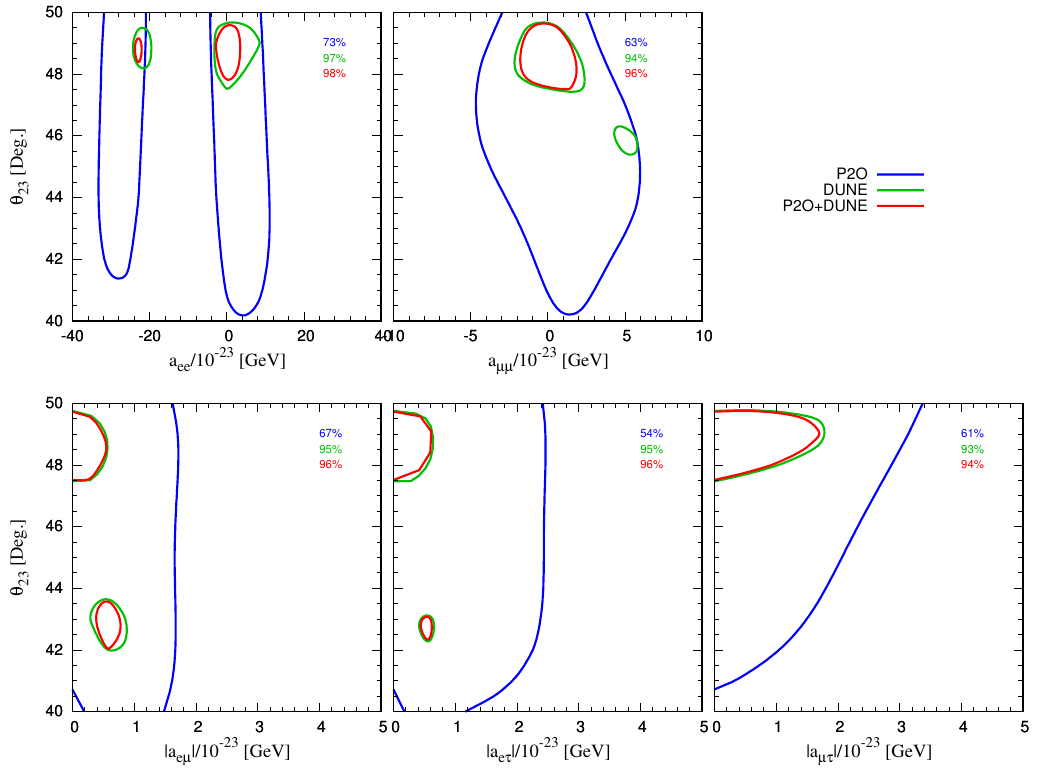
Figure 8 . Similar to figure 7 but showing the correlation of the LIV parameters with θ 23